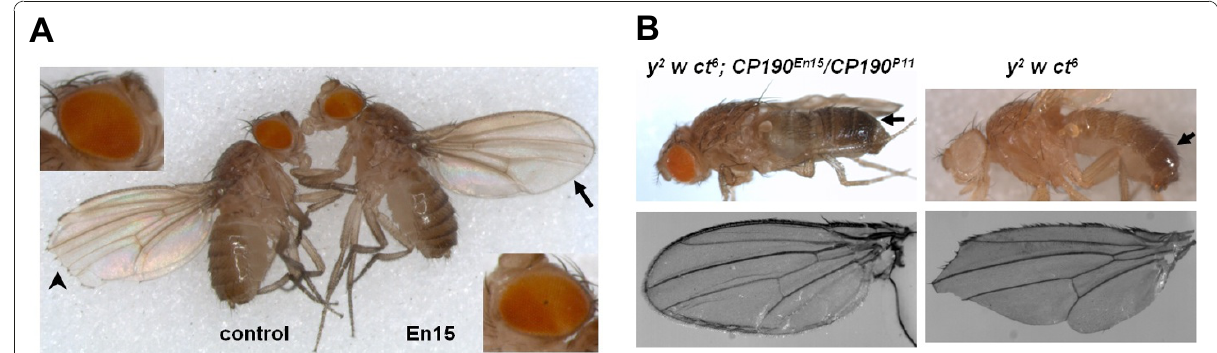
Figure 4 The C-terminal E-rich domain is essential to Cp190 ’ s insulator function . (A) Genetic assays to test functionality of the gypsy insulator in CP190 E15 . Shown are morphological phenotypes of the y 2 w omb P1-D11 ct 6 ; mod(mdg4) T6 e female (left, control) and the y 2 w omb P1- D11 ct 6 ; CP190 En15 mod(mdg4) T6 e/mod(mdg4) T6 e female (right, En15). The En15 fly has a darker abdomen cuticle color (enhanced y 2 phenotype) compared to the control fly. The arrowhead points to the partially suppressed ct 6 wing shape phenotype which lacks some wing margin bristle cells. The arrow points to the fully suppressed ct 6 wing shape (enhanced ct 6 phenotype). The omb P1-D11 pigmentation pattern of the eye of the control female fly is shown on the upper left and the omb P1-D11 pigmentation pattern of the En15 female which has expanded white region in the equatorial part of the eye (enhanced omb P1-D11 phenotype) is shown on the lower right. (B) The body cuticle pigmentation (upper panel) and the wing shape (lower panel) of the CP190 En15 /CP190 P11 mutant (left column) and CP190 + flies (right column). Arrows point to different pigmentation of the